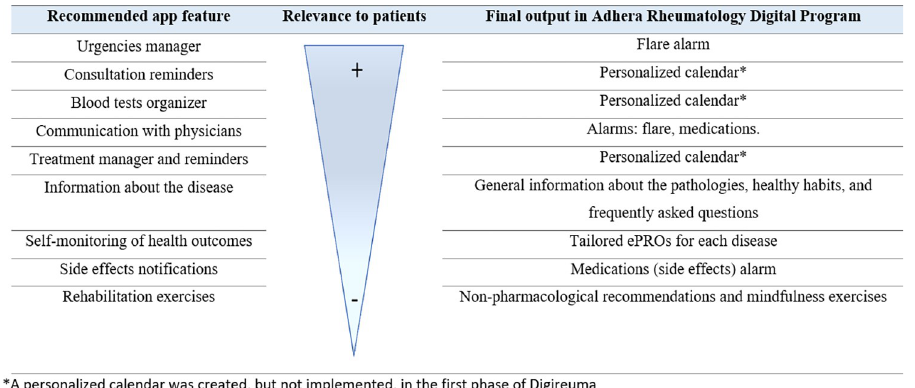
Fig 3. Features requested by patients, by relevance, in the focus group as well as by final output included Adhera Rheumatology Digital Program.